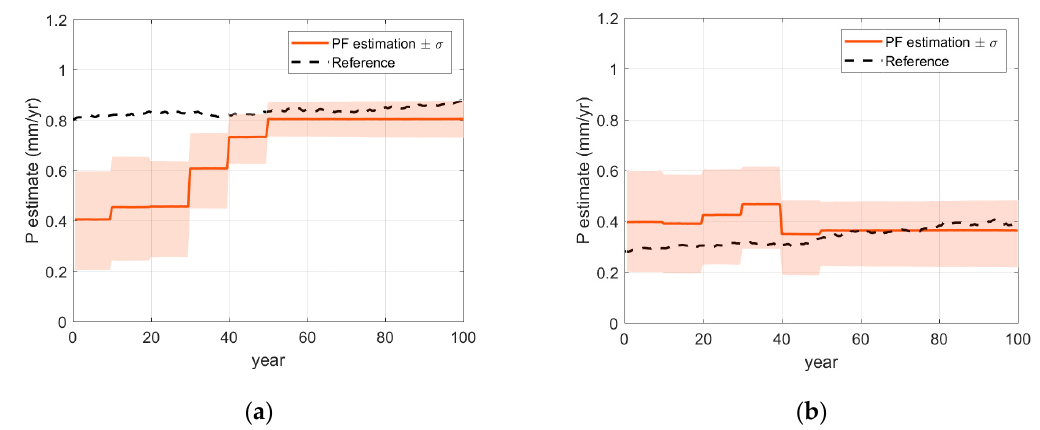
Figure 6. Updating of corrosion model parameters by particle filter at specific locations: ( a ) P at point A; ( b ) P at point B